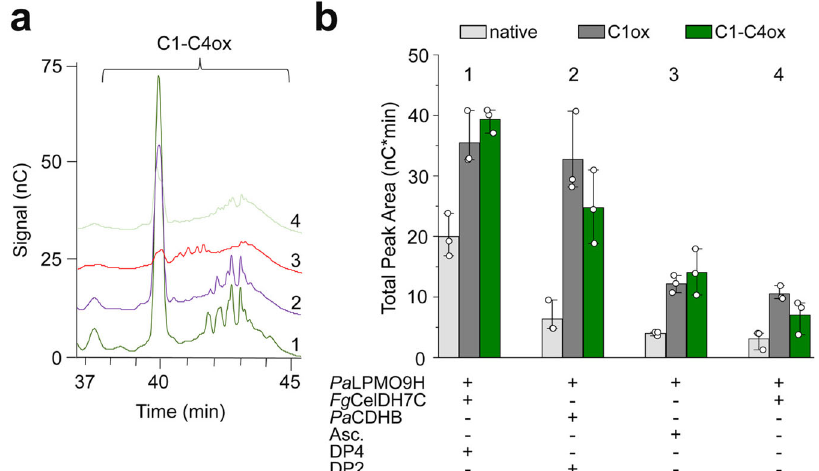
Fig. 4 Analysis of AA7-LPMO interplay in cellulose degradation. Reactions were performed on Avicel using Fg CelDH7C and Pa LPMO9H with subsequent ionic chromatography (HPAEC-PAD) analysis. a A representative chromatogram part showing C1-C4 double-oxidised species in the cellulose degradation assay including combinations of Avicel (5 mg mL − 1 ), Fg CelDH7C (0.4 μ M), Pa LPMO9H (4 μ M), Pa CDHB (1.2 µ M), cellotetraose (DP4, 0.8 mM) and ascorbate (Asc., 1 mM) as indicated in the fi gure. b Comparison of the cellulose degradation assay based on the cumulative area under the peaks of native (DP3, DP5 and DP6), C1 oxidised (except DP2 and DP4 which were added as substrates for the CDH and AA7, respectively) and C1-C4 double-oxidised cellooligosaccharides from the reactions in ( a ). The data in ( a ) and ( b ) ( n = 3 independent reactions) were generated in NaOAc/NaOH buffer (50 mM, pH 5.2) at 35 °C. The bar plot in ( b ) shows the means of total peak area ( n = 3 independent reactions, each shown as a white circle) with standard deviations. Source data are provided as a Source Data fi